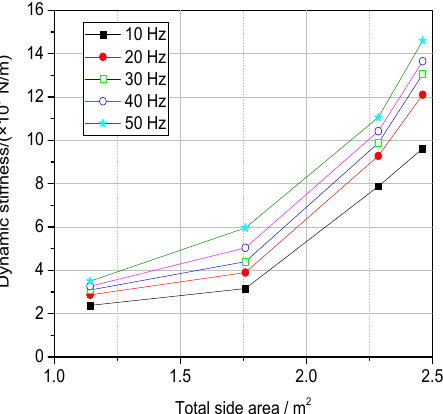
Figure 9. Relationships between the dynamic stiffnesses and total side areas of the ground piles.